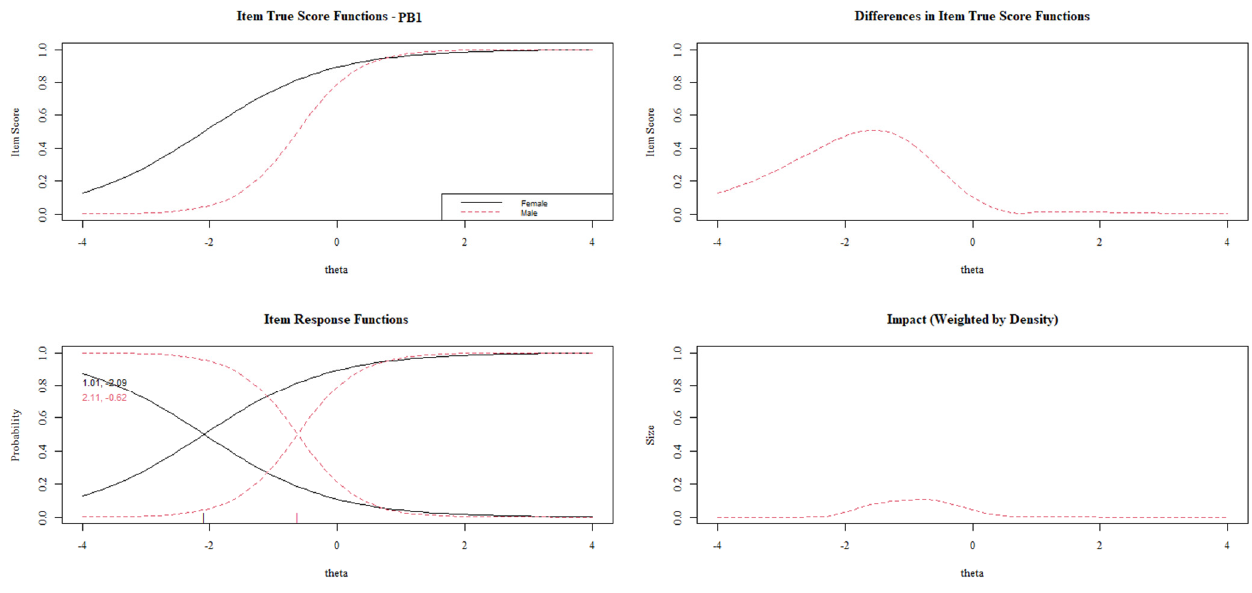
Figure 3. DIF plots for item PB1.